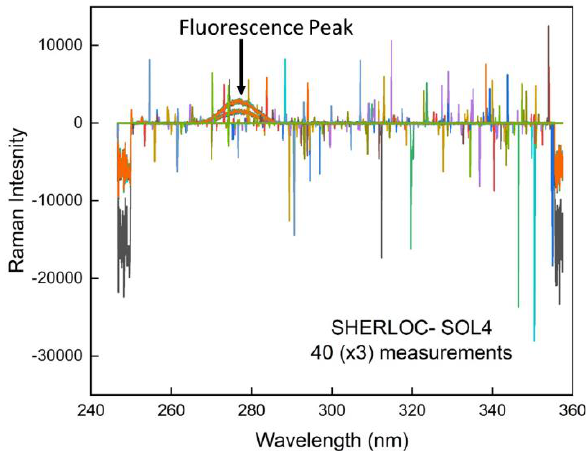
Figure 3. SHERLOC measurements for Sol 4 Table 1 . Major Spectral features observed on